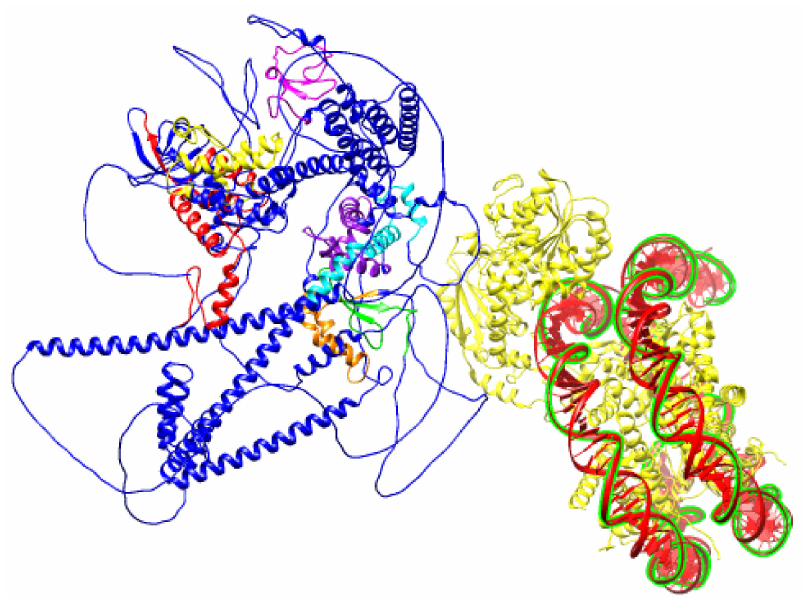
Figure 6. Schematic prediction of SNF2H SANT domain bound to DNA (PDB ID:6NE3) and BAZ1B protein (PDB ID: Q9UIG0) facing it with an ISWI binding pocket comprised of DDT, WHIM1, WHIM2, and WHIM3